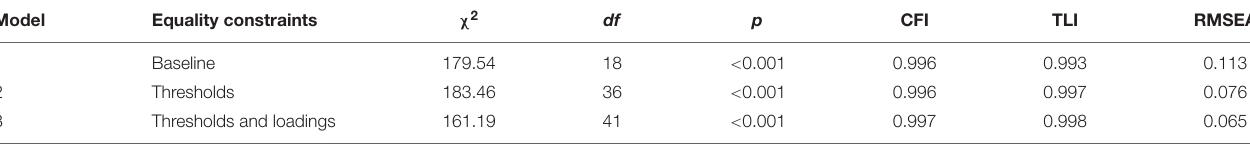
TABLE 1 | Measurement invariance of math self-concept between gender groups.